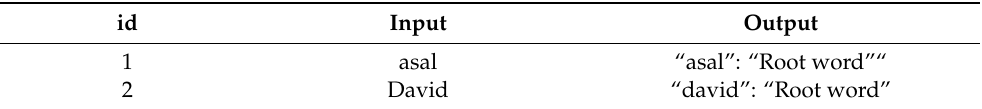
Table 15. Morphological analysis of words. Words will not be stemmed, because there are not any endings for doing stemming of these words.